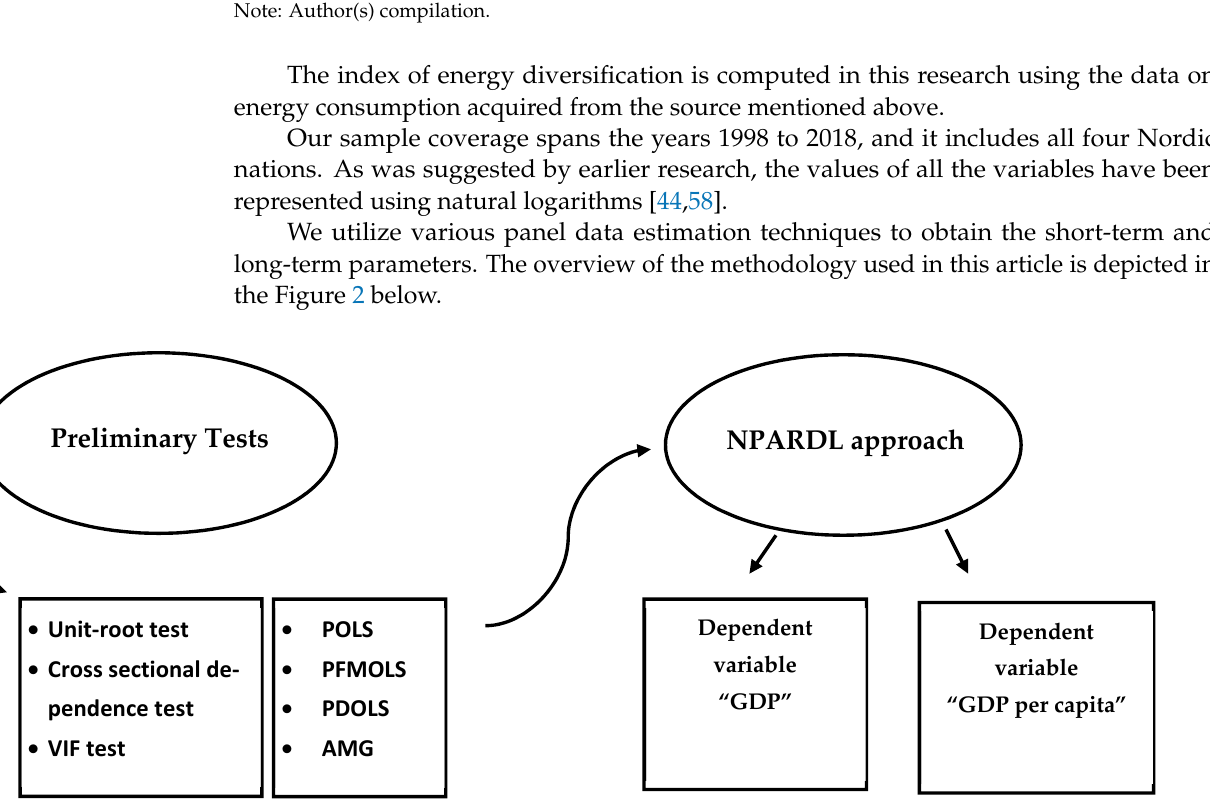
Figure 2. Overview of the methodology.